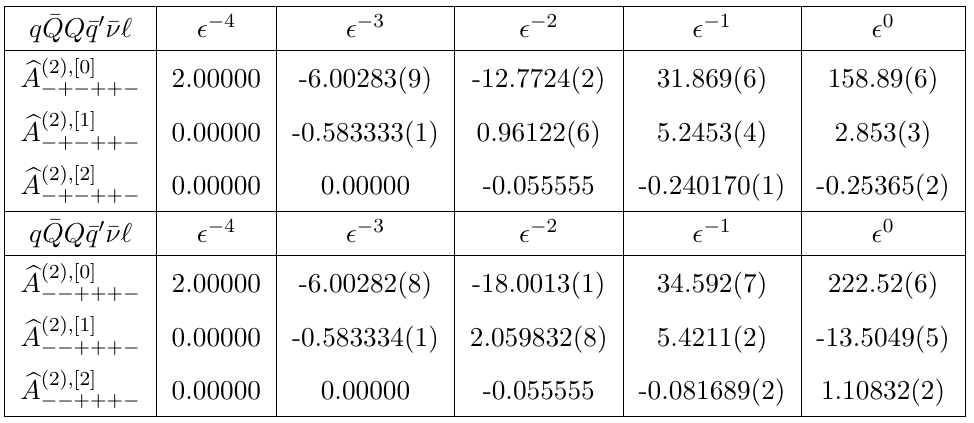
(cid:1) using kinematic point in eq. (5.1)